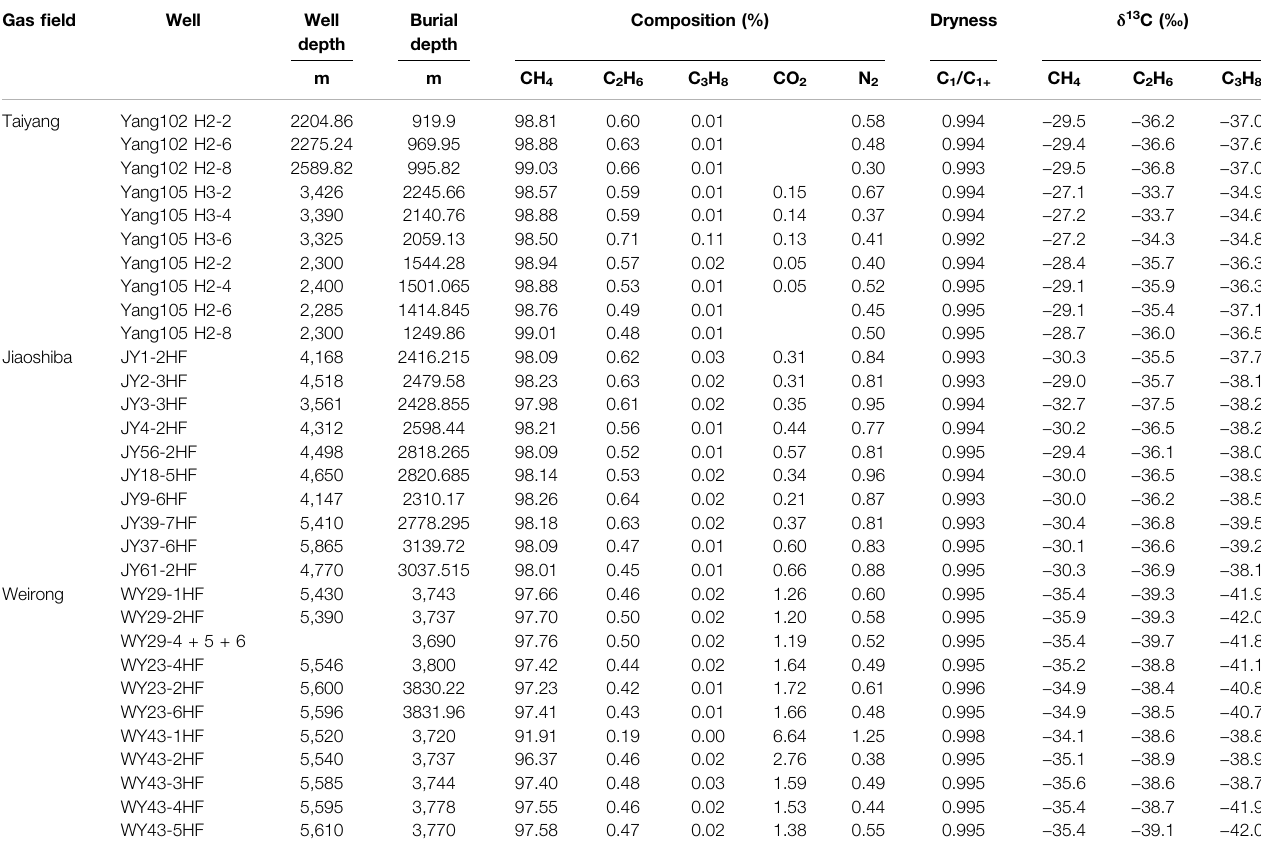
TABLE 1 | Molecular and carbon isotopic composition of gas samples from the Upper Ordovician Wufeng – Lower Silurian Longmaxi formations in the Taiyang, Jiaoshiba, and Weirong shale gas fi elds in the Sichuan Basin, China. Gas fi eld Well Well Burial Composition (%) Dryness δ 13 C ( ‰ ) depth depth